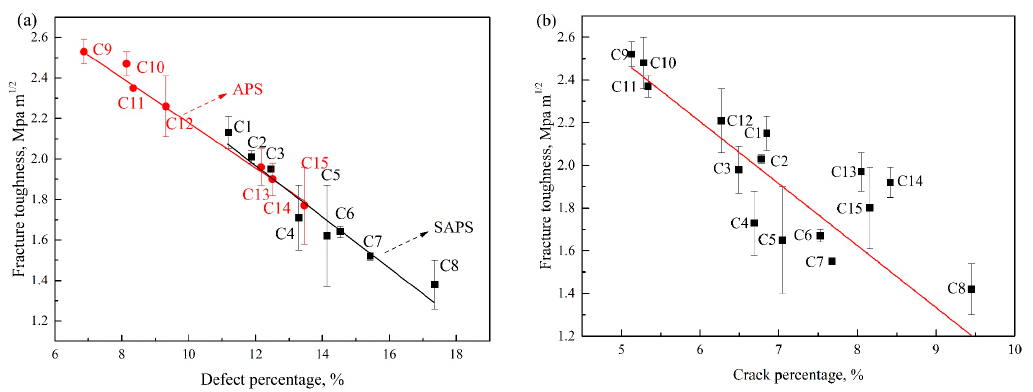
Figure 8. The fracture toughness of SAPS- and APS-TBCs with ( a ) defect percentage and ( b ) crack percentage.